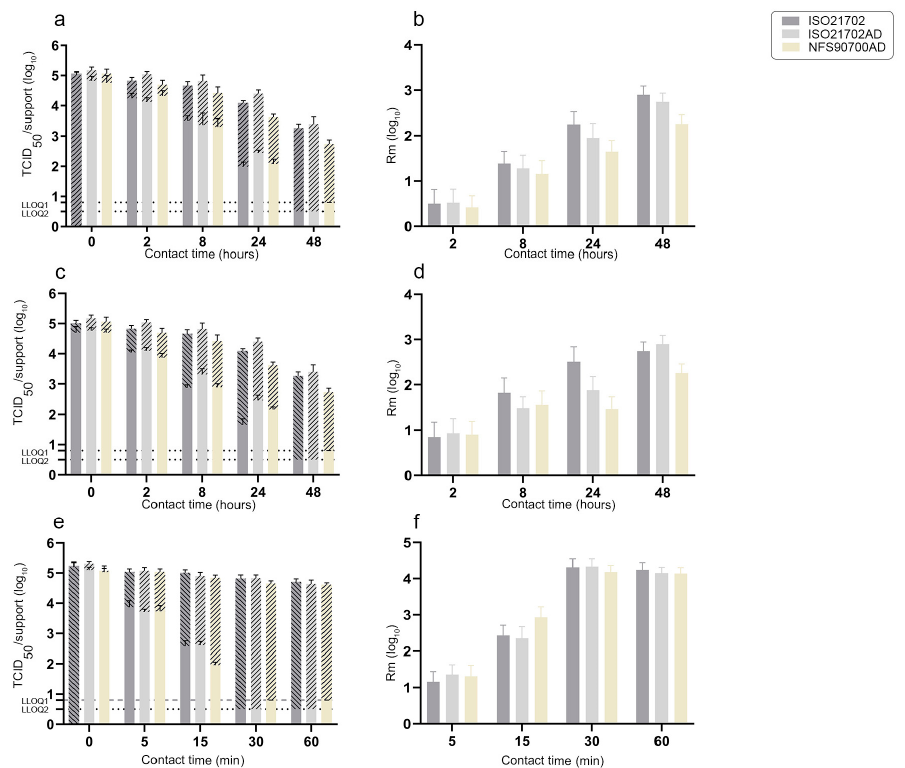
Figure 3. Amount of infectious feline calicivirus at 0, 2, 8, 24 and 48 h post application ( a , c ) or at 0, 5, 15, 30 and 60 min post application ( e ) on both active surfaces (plain box) and stainless steel supports (hatched box) using ISO21702, ISO21702AS and NFS90700AD protocols (mean ± SD, 9 supports/condition). Average antiviral activities Rm (log 10 TCID 50 /cm 2 ), including 95% confidence interval (Kr, 3 independent experiments) using ISO21702, ISO21702AS and NFS90700AD protocols ( b , d , f ). ( a , b ): AS01; ( c , d ): AS02; ( e , f ): AS03. LLOQ: lower limit of quantification (LLOQ2 = 0.5 log 10 TCID 50 for the ISO21702/ISO21702AD protocols and LLOQ1 = 0.8 log 10 TCID 50 for the NFS90700AD